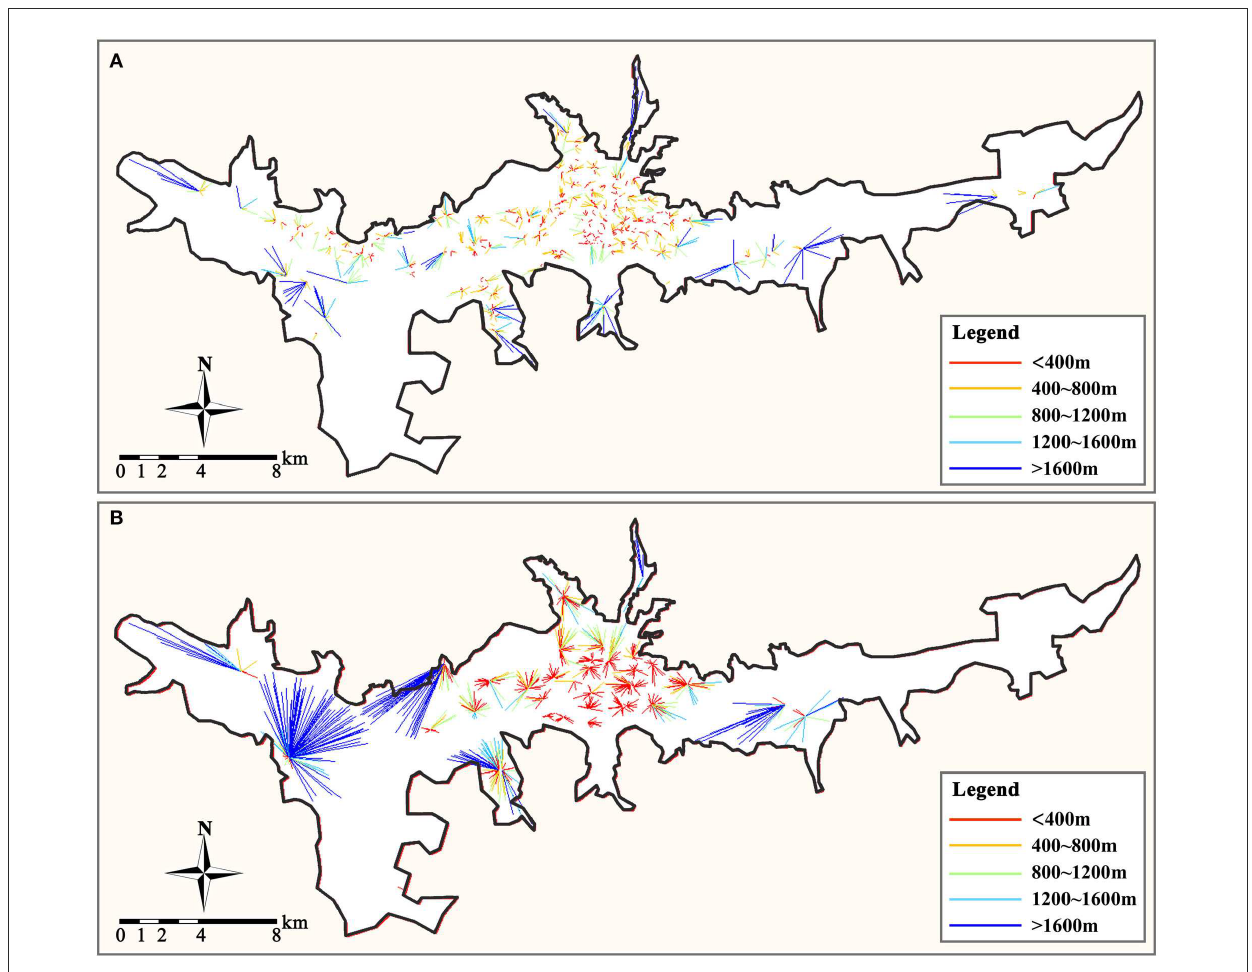
FIGURE6 Spatial distribution of Origin-Destination links. (A) From residences to community clinic. (B) From residences to health